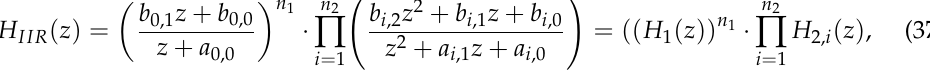
Table 3. Digital biquadratic topology implementations; all difference equations implement the same input-output second-order transfer function, but differ through the configurations of the state signals.